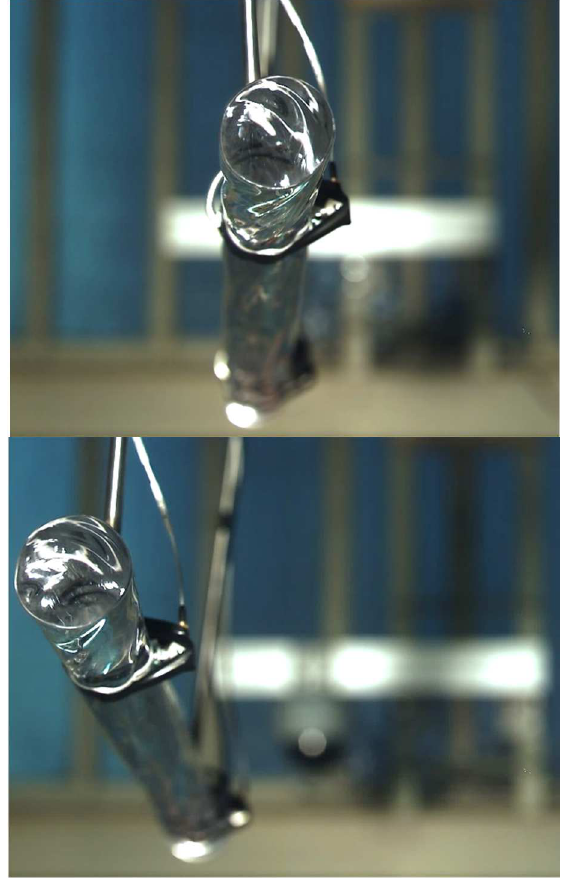
Fig. 16. Images for deflection evaluation a, calm state eq. any load b, maximum wind